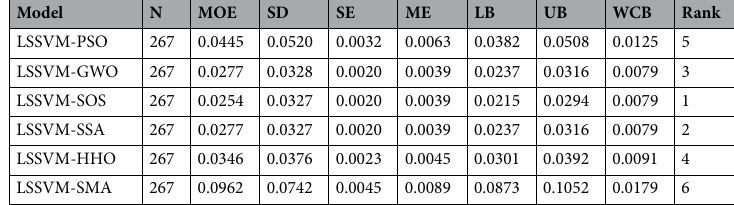
Table 7. Results of UA.